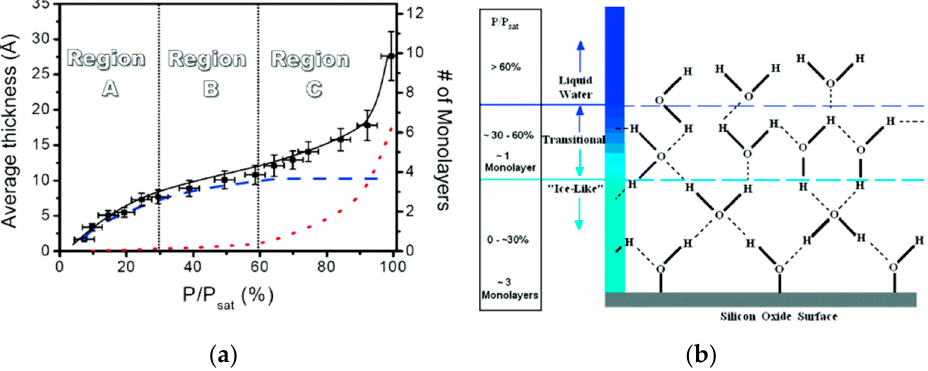
Figure 8. ( a ) Adsorption isotherm of adsorbed water layer on silicon oxide surface estimated based on the ATR-IR spectra of O-H stretching region measured at room temperature. Regions A, B, and C are marked to demonstrate the growth of ice-like water at low RH ( < ~30%), transitional growth from ice-like structure to liquid-like structure at middle RH (~30% < RH < ~60%), and the growth of liquid water at high RH ( > ~60%). ( b ) Schematic illustrating the structural evolution of adsorbed water layer on hydrophilic silicon oxide surface. Reprinted from Ref. [10], Copyright 2005, with permission from ACS publications.